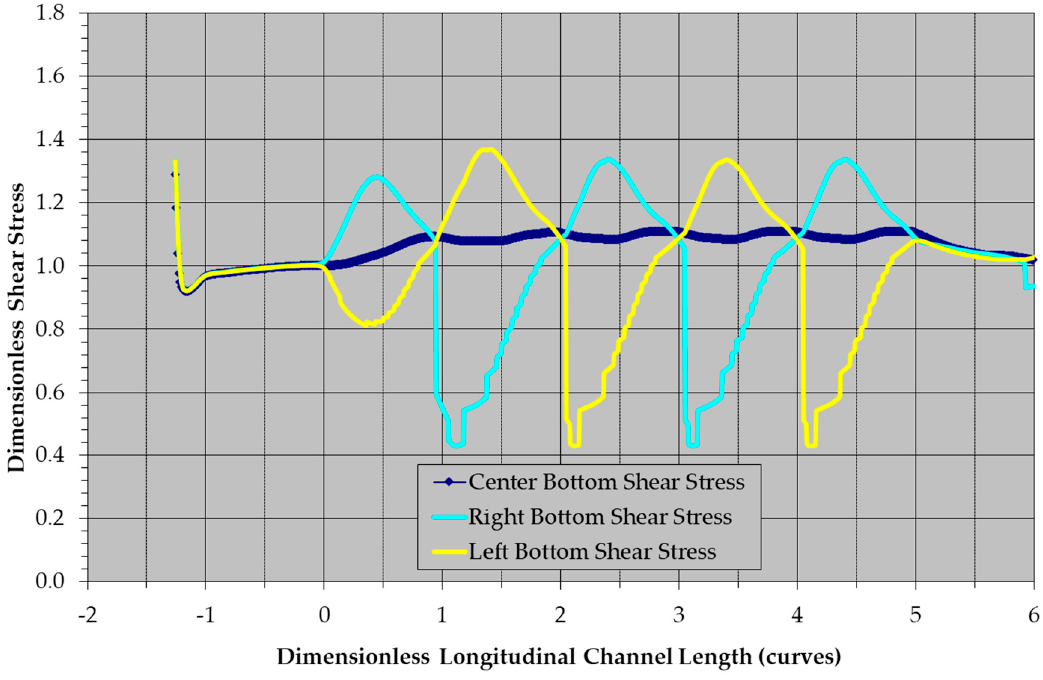
Figure 43. Dimensionless shear stress along the channel centerline, left and right banks for Simulation Set 9 with a sinuosity of 2.00 and a width/depth ratio of 35.6.